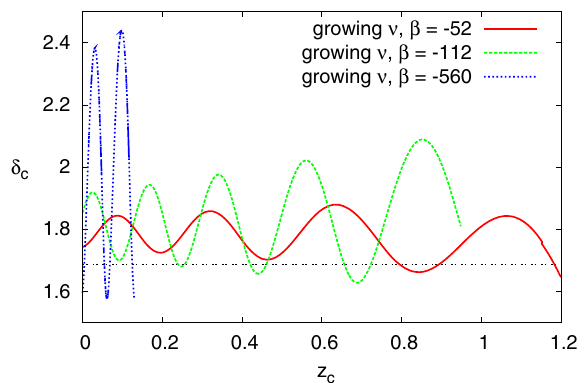
Fig. 7 Extrapolated linear density contrast at collapse δ c versus collapse redshift z c for growing neutrinos with β = − 52 (solid, red), β = − 112 (long-dashed, green) and β = − 560 (short-dashed, blue). A refer- ence EdS model (double-dashed. black) is also shown. Image reproduced by permission from Wintergerst and Pettorino (2010); copyright by